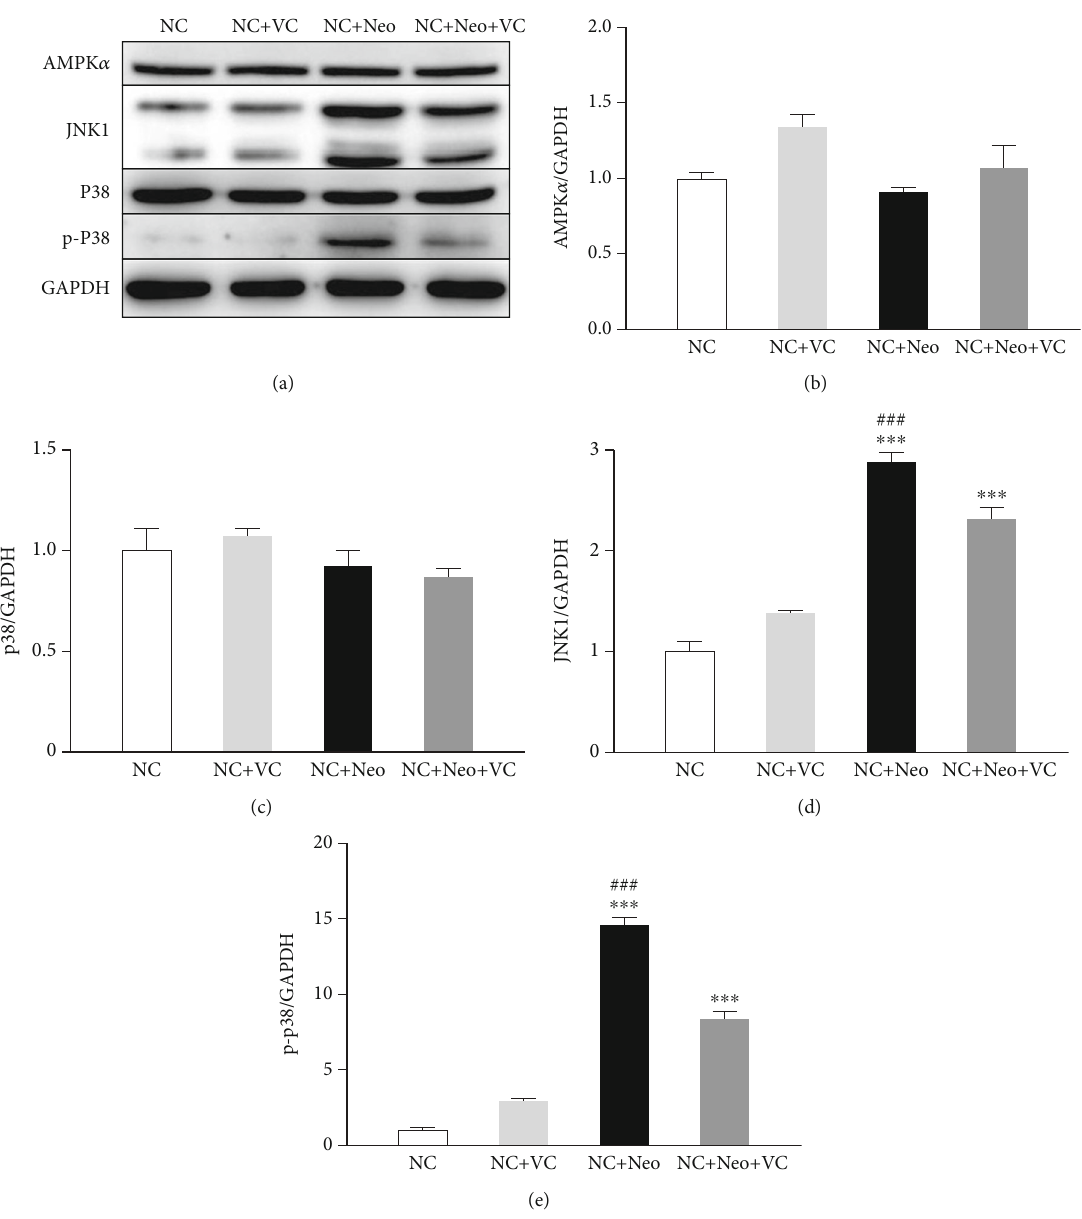
Figure 10: VC-related neomycin-induced HEI-OC1 cell apoptosis pathway. Pathway proteins related to apoptosis were detected. The protein expression was detected by Western blot. The expressions of AMPK α , JNK1, p38, and p-P38 were detected (a). The protein expression level was measured with each band gray value, normalized to GAPDH (b – e). One-way ANOVA, ∗∗∗ p < 0 : 001 versus NC group and ### p < 0 : 001 versus NC+Neo+VC group. All tests were repeated three times